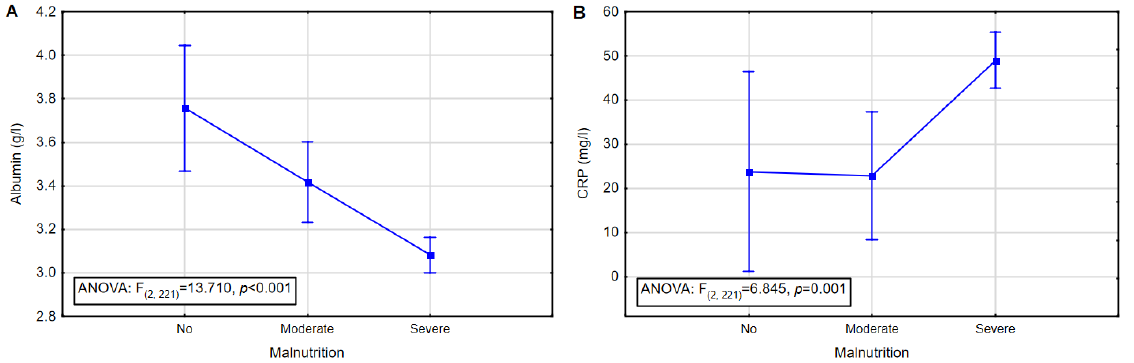
Figure 2. One-way ANOVA results of Albumin and CRP in HNC patients. ( A ) Albumin; ( B ) CRP. The midpoint is the mean value, and the vertical line represents the 95% confidence interval.